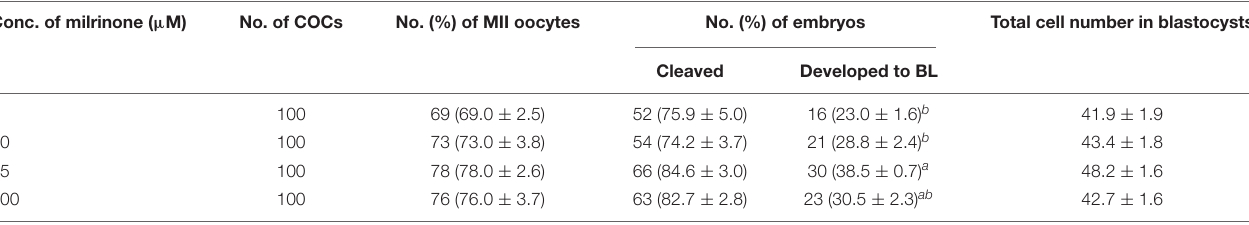
Values in the same column with different superscript letters are significantly different (p < 0.05). Percentages and the total cell number in BL are shown as means ± SEM (n = 4 replicates). BL, blastocyst; COC, cumulus–oocyte complex. TABLE 5 | In vitro development of porcine cloned embryos after treatment with four different milrinone concentrations in the brilliant cresyl blue non-stained (BCB − ) oocytes. Conc. of milrinone ( µ M)